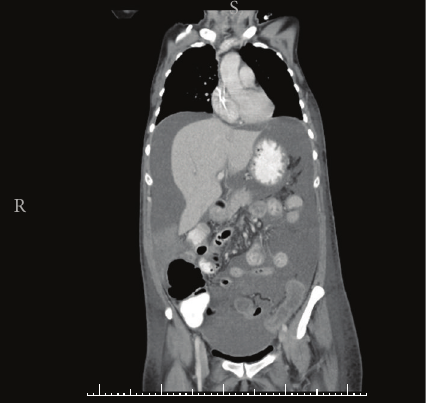
Figure 1: Computed tomography of the abdomen and pelvis showing colonic wall thickening and ascites in patient 4 with full- thickness eosinophilic colitis.